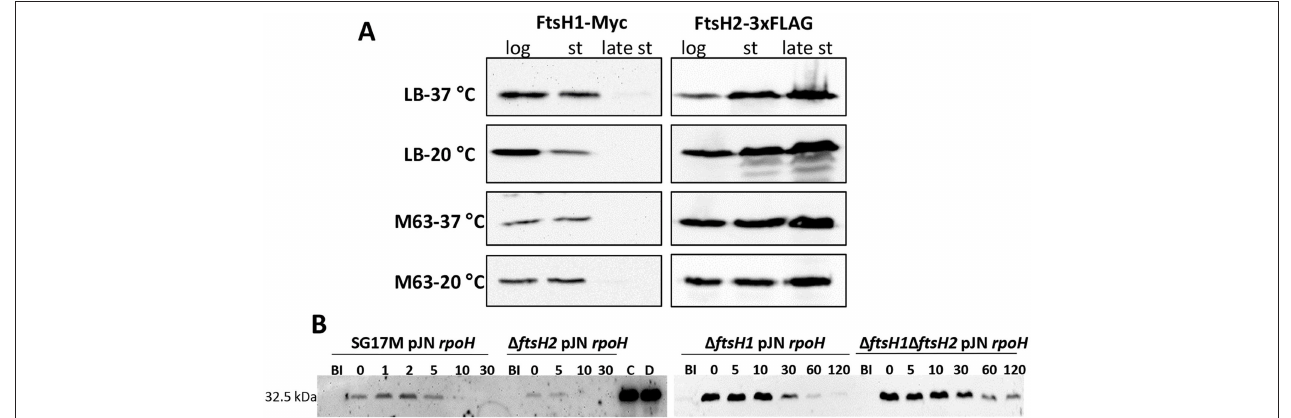
FIGURE 2 | Differential production of FtsH1 and FtsH2 during the growth phase and in vivo degradation of the sigma factor RpoH by FtsH proteases in P. aeruginosa SG17M. (A) Production of FtsH1-Myc and FtsH2-3xFLAG assessed in the logarithmic (log), stationary (st) and late stationary phase (late st) at 37 and 20 ◦ C in LB and M63 medium. In LB medium, the logarithmic phase equals OD 600 = 1 and late stationary phase OD 600 = 4 (26h at 37 ◦ C; 47 h at 20 ◦ C). Stationary phase in LB medium equals OD 600 = 2.5 at 20 ◦ C (18 h) and OD 600 = 4.5 at 37 ◦ C (8h). In M63 medium at both temperatures, logarithmic phase equals OD 600 = 0.25, stationary phase OD 600 = 0.6 (8 h at 37 ◦ C; 30h at 20 ◦ C) late stationary phase OD 600 = 0.8 (26 h at 37 ◦ C; 120h at 20 ◦ C). One blot of two independent biological replicates with congruent results is shown. (B) 6xHis-RpoH degradation after plasmid-borne induction for 30min as assessed by Western blotting in the wild type P. aeruginosa SG17M, 1 ftsH2 , 1 ftsH1, and 1 ftsH1 1 ftsH2 background. BI (Before Induction) refers to the sample before a 30min expression of rpoH from plasmid pJN105 with 1% L-arabinose. Numbers above the blot represent time in min after termination of translation with 300 µ g ml − 1 spectinomycin. Lanes marked with